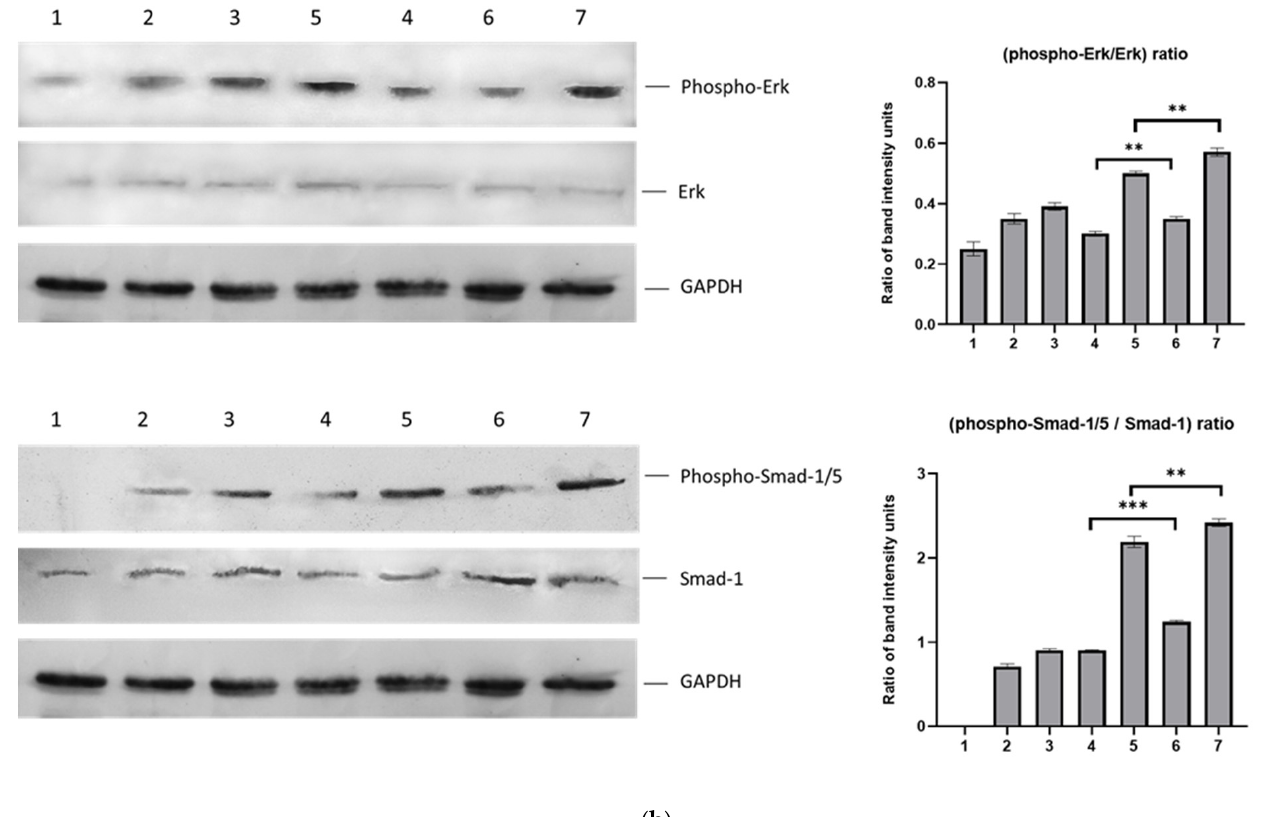
Figure 9. ( a ) Relative quantification of the mRNA levels of osteogenic markers ALP , Osteocalcin, RUNX2 , COL1A1 , BMPR1A , and BMPR2 after 21 days of differentiation of hDPSCs on the scaffolds and without scaffold. The normalization of Ct values was performed against two housekeeping genes, GAPDH and RPLPO . ( b ) Western blotting against phospho-Erk1/2, Erk1/2, phospho-Smad-1/5, and Smad-1 in protein extracts after 21 days of differentiation of hDPSCs. The bar charts depict phospho-Erk/Erk and phospho-Smad-1/5/Smad-1 ratios after quantification of band intensities in the blots, using the ImageJ 1.53t software. The data are presented as the mean ± SD values ( n = 3). Asterisks (*), (**), and (***) indicate statistically significant differences ( p ≤ 0.05, p ≤ 0.01, and p ≤ 0.001, respectively) compared to control